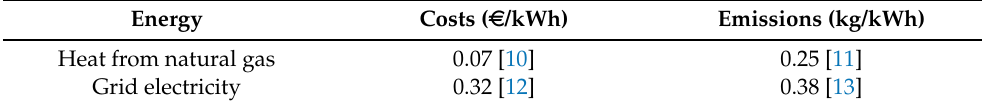
Table 1. Costs and emissions of heat from natural gas and grid electricity for recent years in Germany. Energy Costs ( e /kWh) Emissions (kg/kWh) Heat from natural gas 0.07 [10] 0.25 [11] Grid electricity 0.32 [12] 0.38